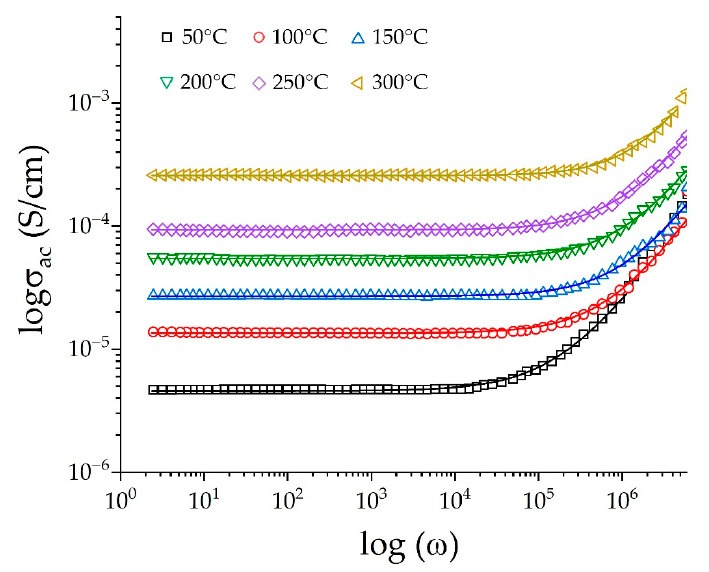
Figure 7. Frequency dependences of AC conductivity in the temperature range 50–300 °C.